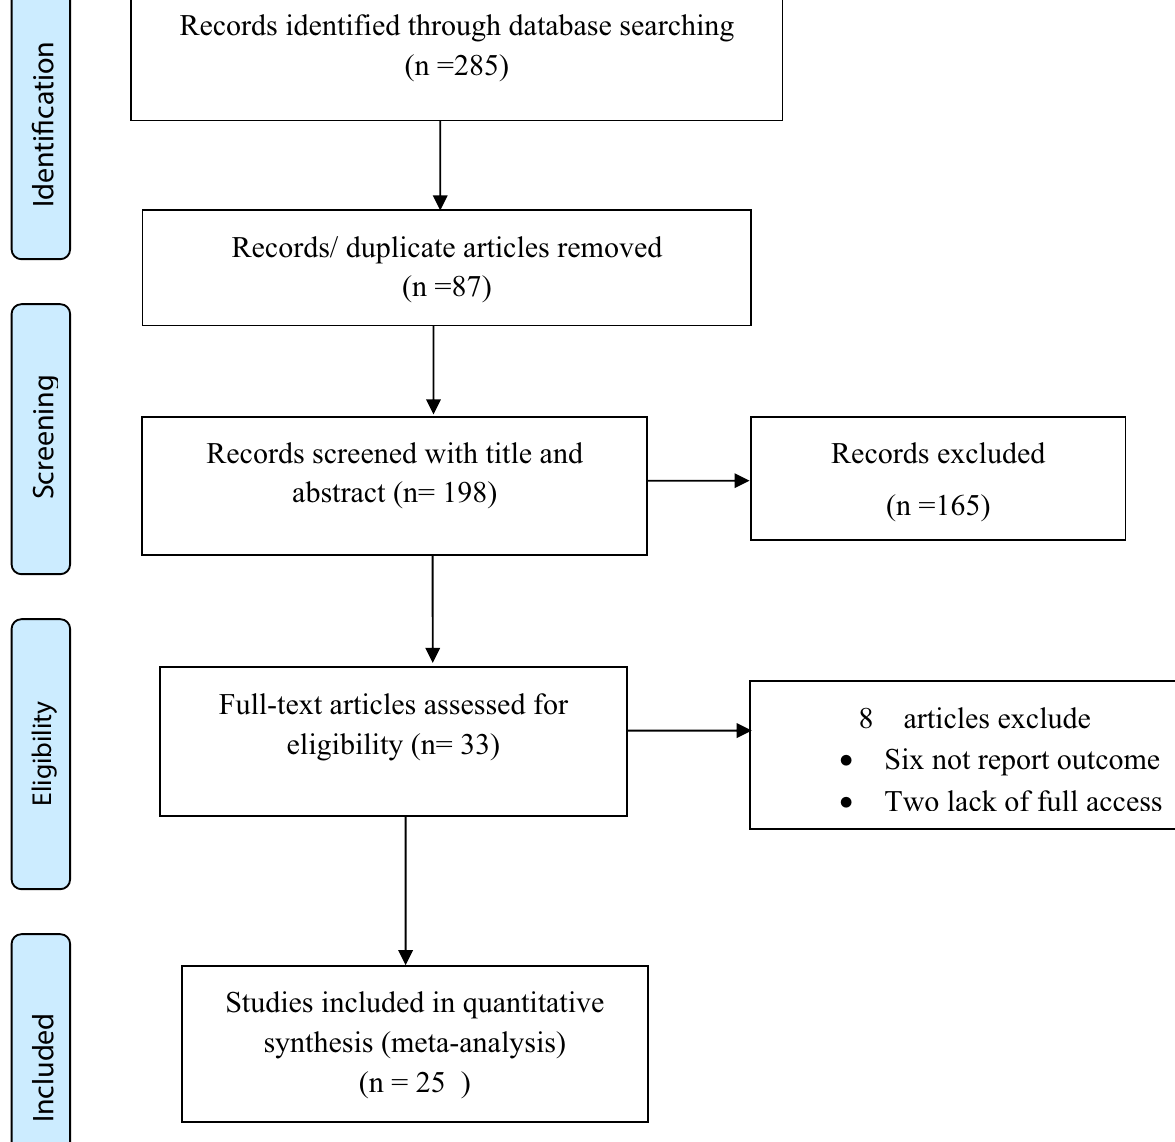
Figure 1. PRISMA flow diagram of the included studies in the systematic review and meta-analysis to estimate perinatal mortality in